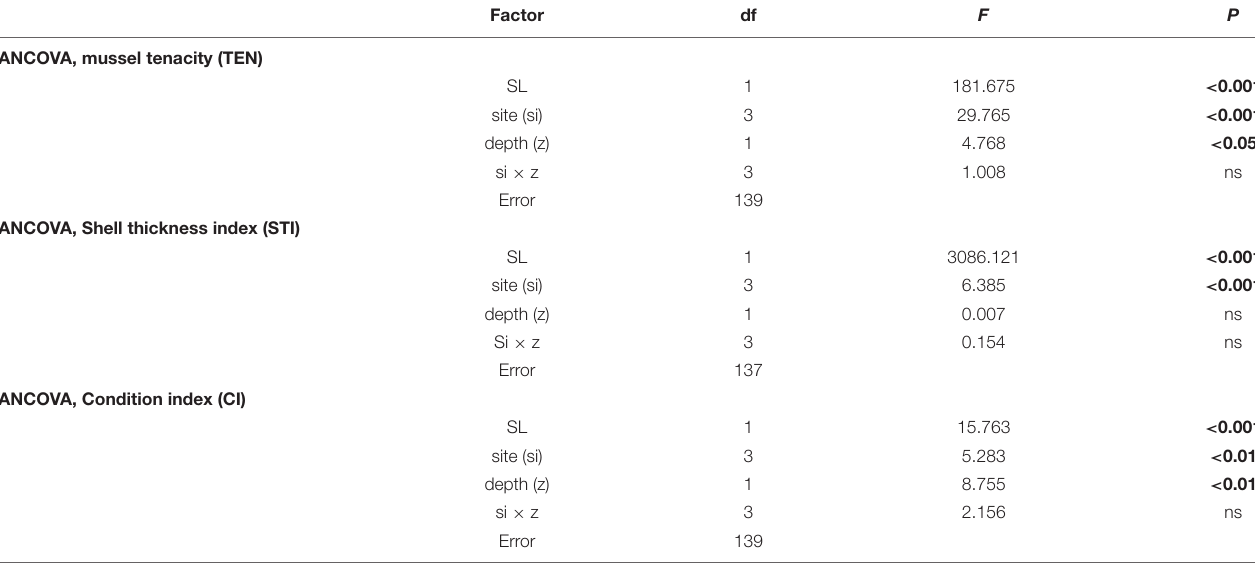
TABLE 2 | Results of ANCOVAs to determine the effect of cultivation site (si) and depth (z) on mussel tenacity (TEN), shell thickness index (STI), and condition index (CI) variability. Factor df F